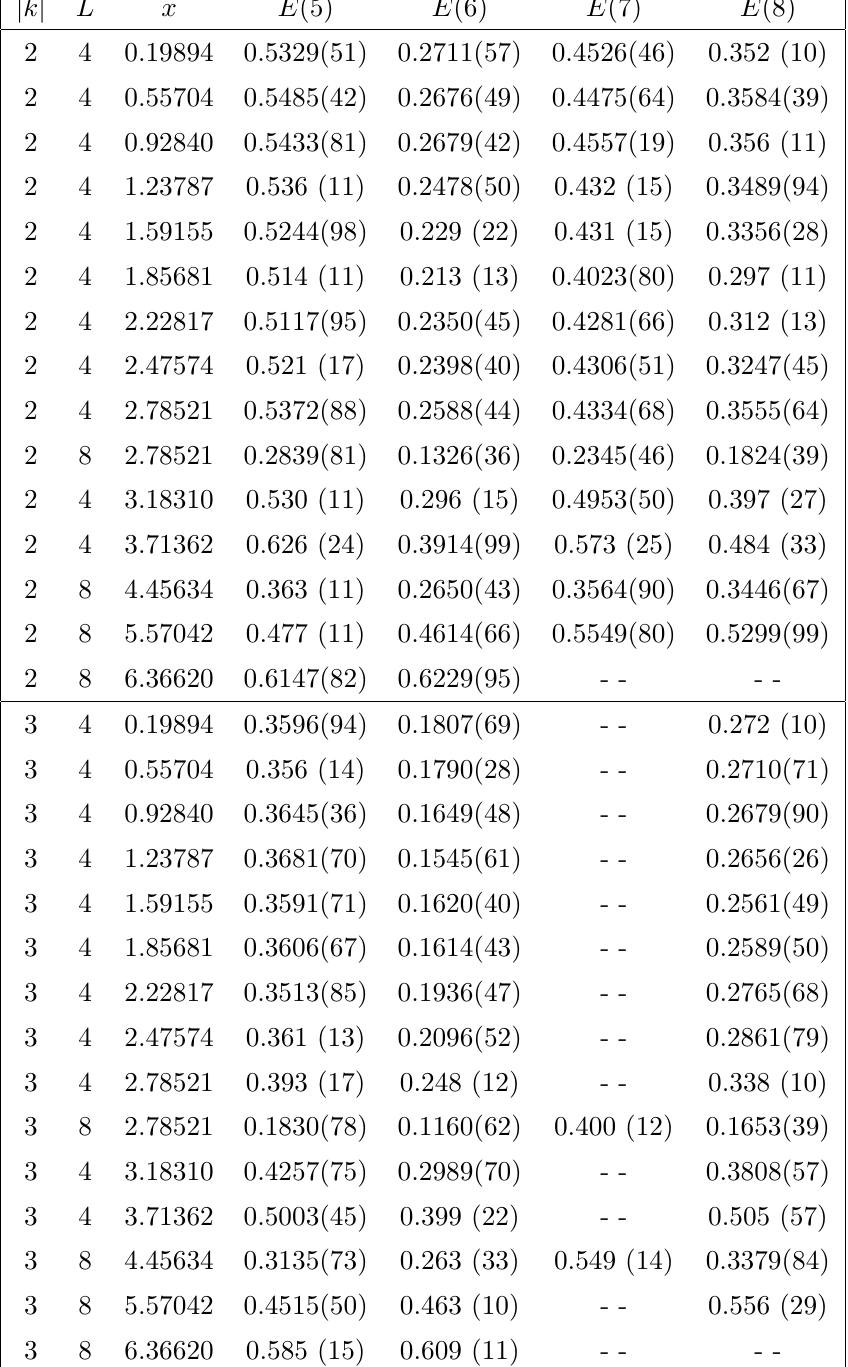
Table 13. SU(17) torelon energies (in lattice units)